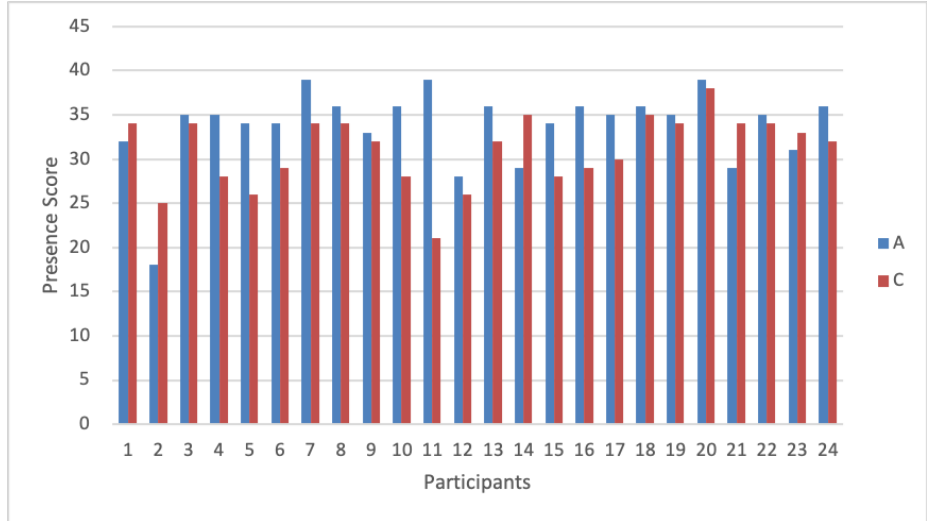
Figure 4. Presence score for Programs A and C in Experiment